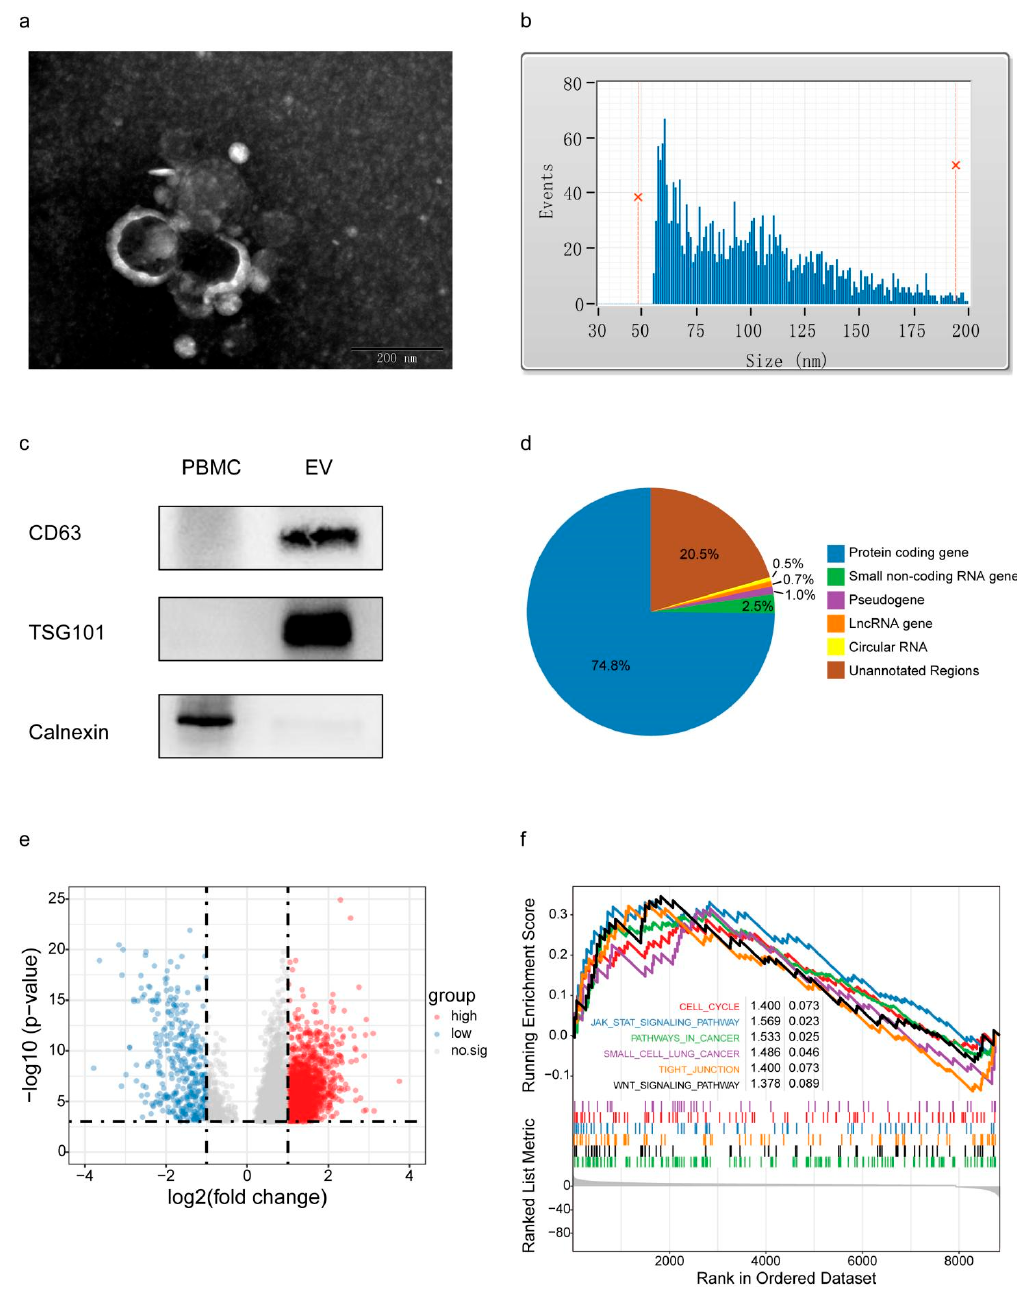
Figure 1. Plasma EV confirmation and exLR-seq analysis. ( a ) Transmission electron microscopy image of isolated vesicles, scale 200 nm. ( b ) Particle size analysis of isolated vesicles. ( c ) Western blots of calnexin, which should be detected in PBMC, but not in isolated vesicles, used as controls. EV markers TSG101 and CD63 detected in isolated vesicles, but not in PBMC. ( d ) Distribution of mapped reads to the annotated genes and identified circRNAs. ( e ) Volcano plot of differential expressed exLRs between SCLC and healthy controls. ( f ) The KEGG pathway enriched in the SCLC group by GSEA. EV: extracellular vesicle; PBMC: peripheral blood mononuclear cell; exLR: EV long RNA; SCLC: small-cell lung cancer; GSEA: gene set-enrichment analysis.